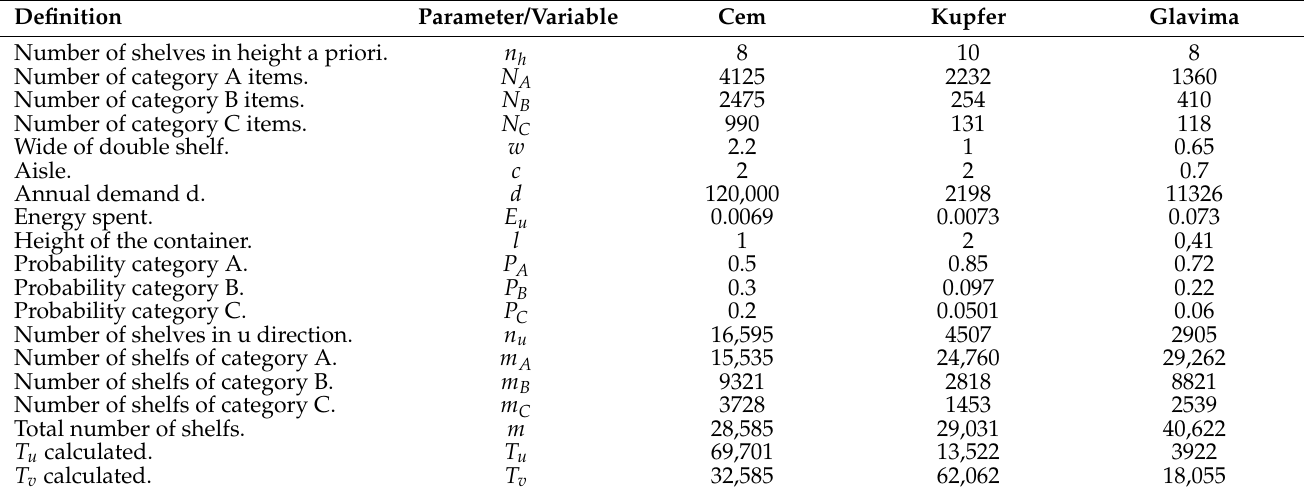
Table 8. Calculation with free area.